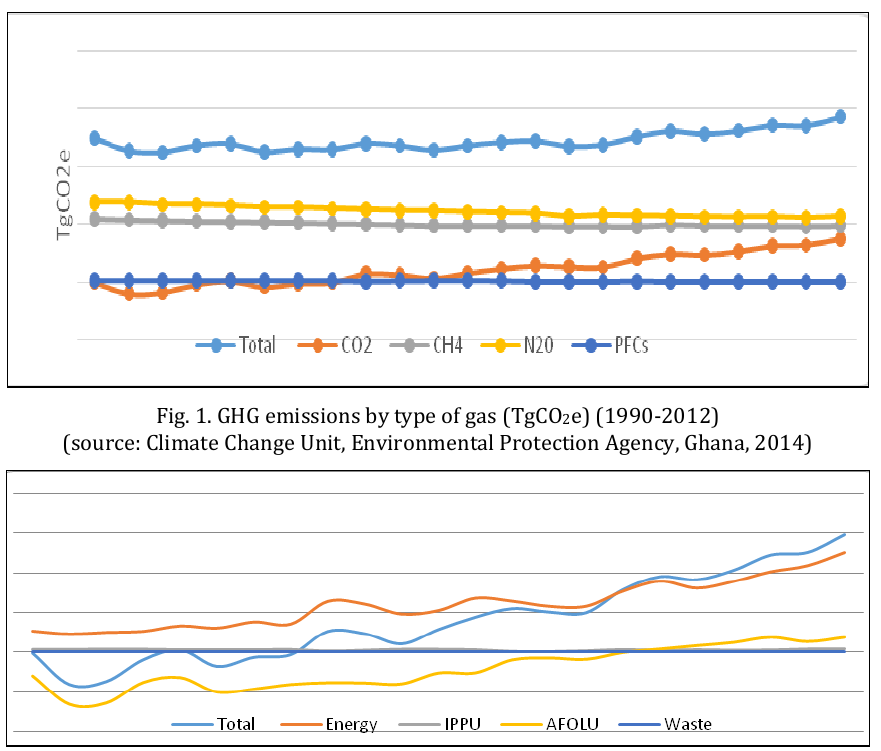
Fig. 2. Trends in CO 2 emissions by sector (source: Climate Change Unit, Environmental Protection Agency, Ghana,